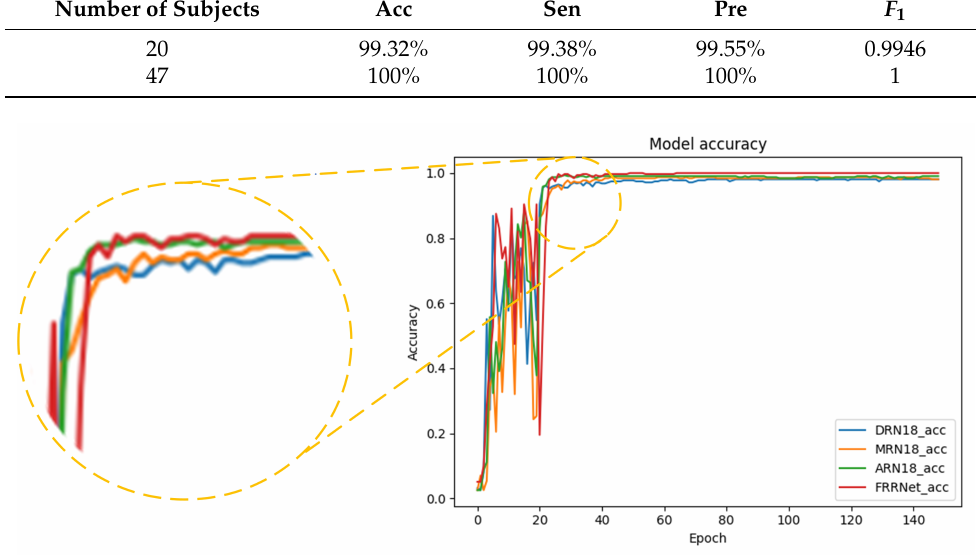
Figure 8. Network model training process demonstration in the MIT-BIH dataset: Comparison of accuracy convergence.